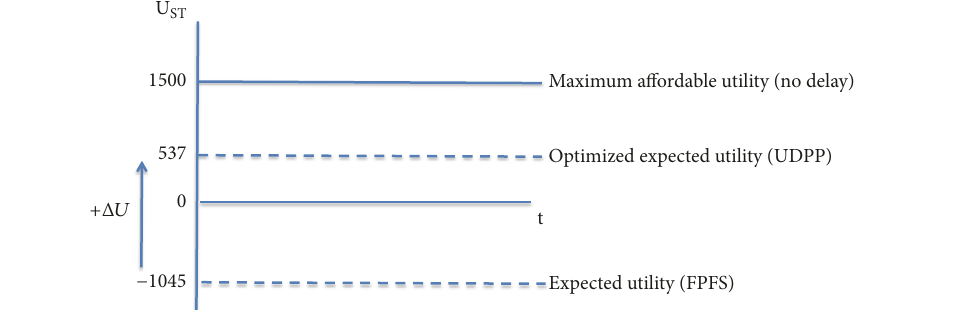
Figure 18: Change in utility after